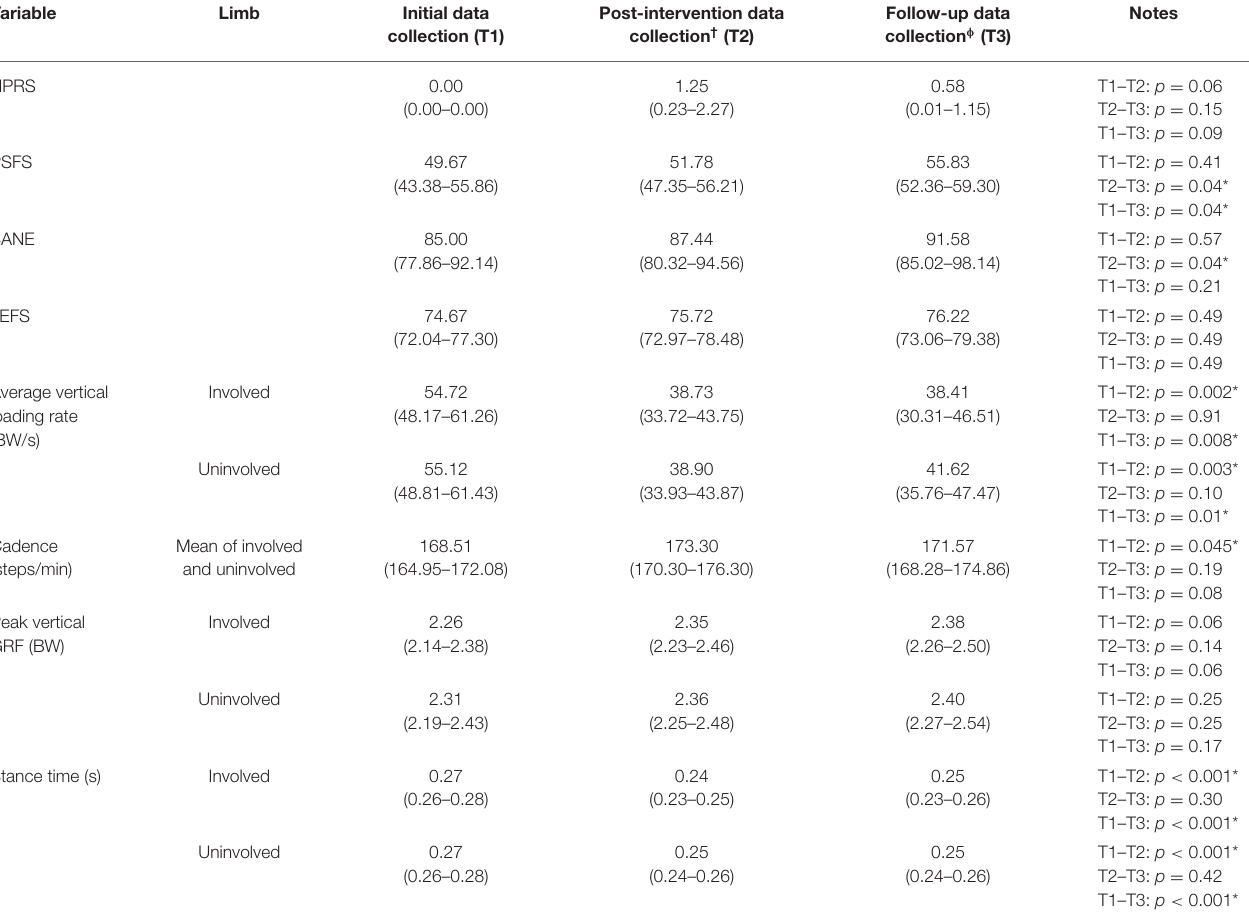
TABLE 3 | Repeated measures analysis of variance pairwise comparison with Holm correction for participants who transitioned to a NRFS running pattern ( n = 18 # ).